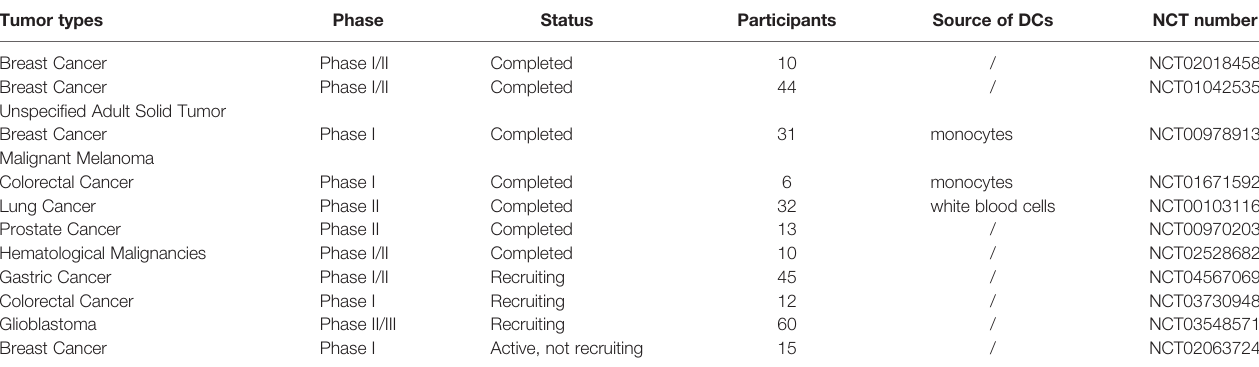
TABLE 2 | The clinical application of DC